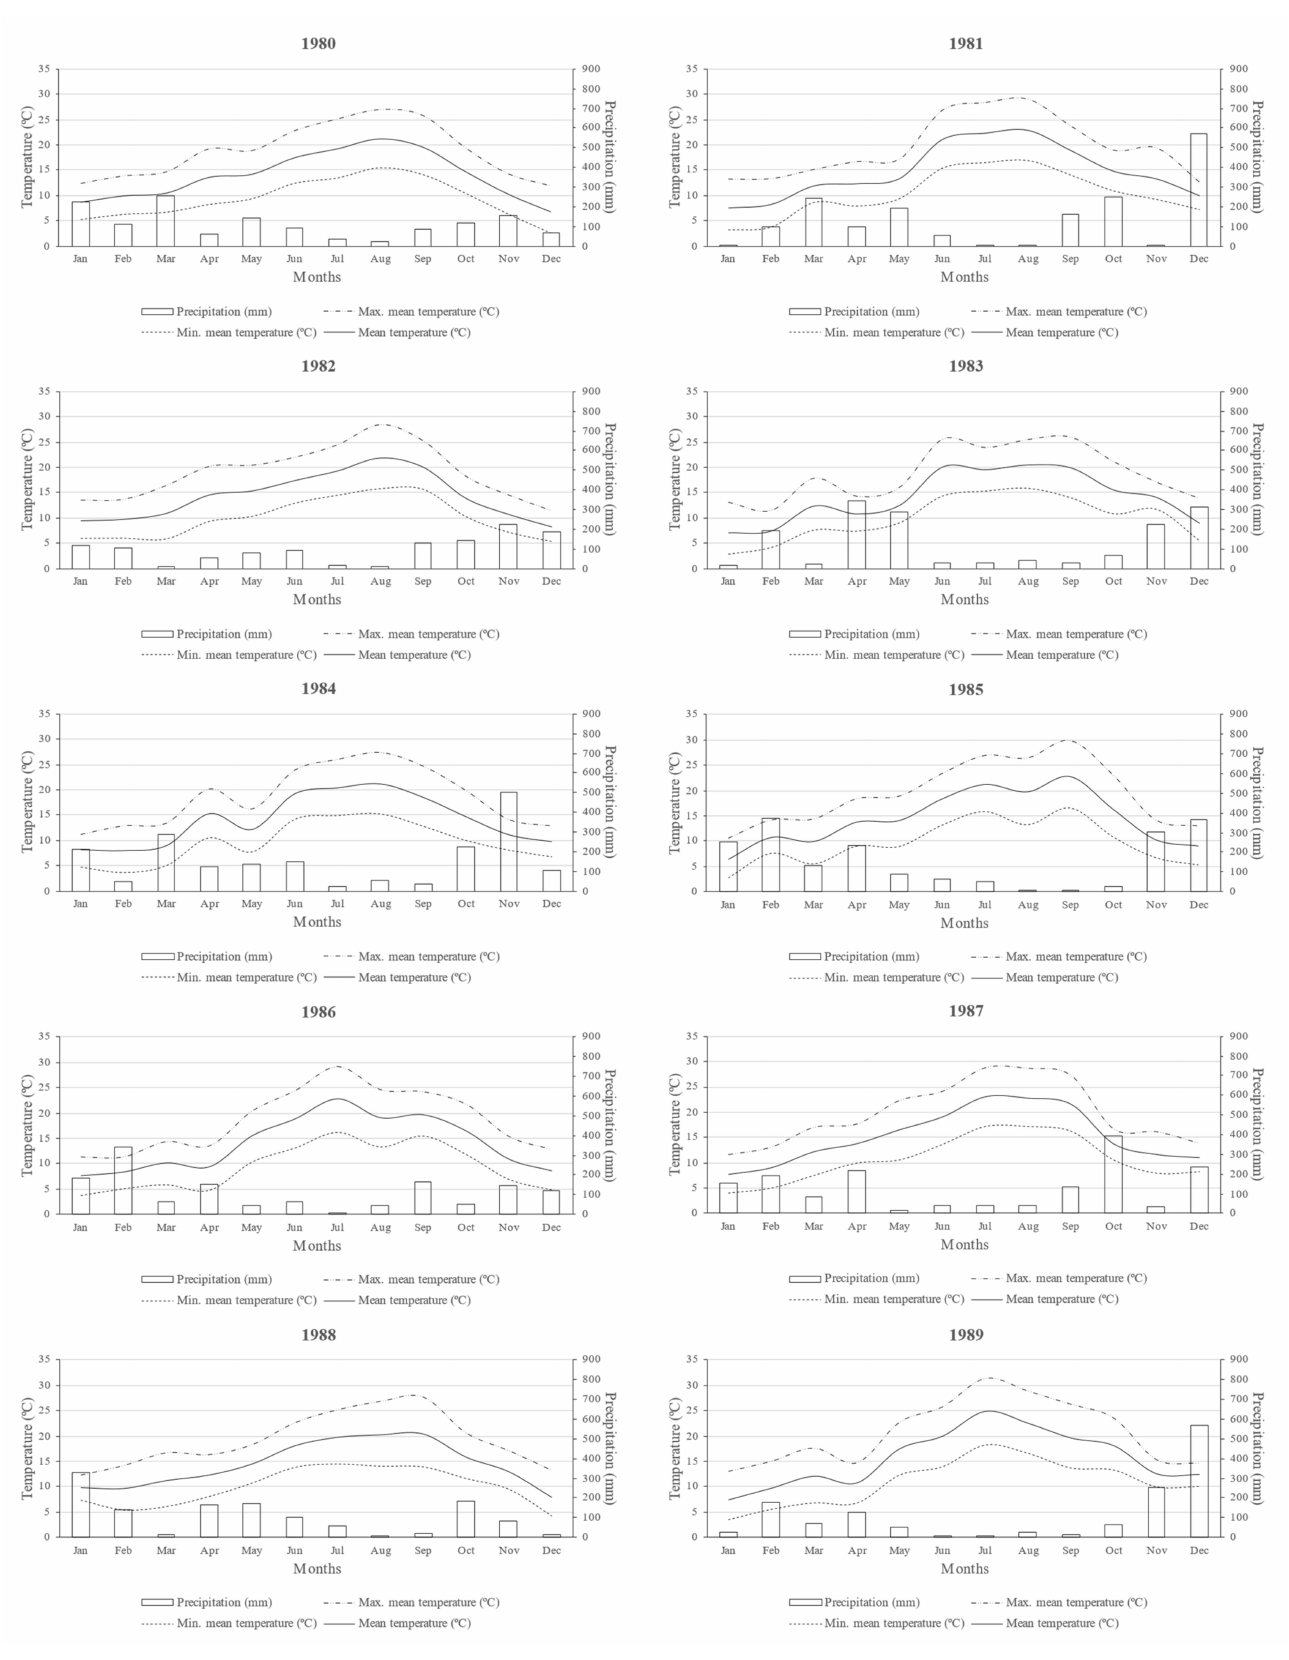
Figure 3. Distribution of climatic parameters for the decade of